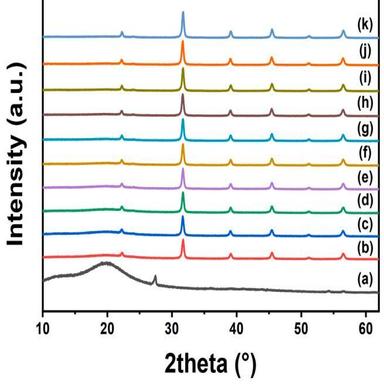
Diffraction pattern overlay of 3D printed BST/ABS composites. (a = 0 wt%, b = 9.10 wt%. c = 16.64 wt%, d = 23.40 wt%, e = 28.56 wt%, f = 33.25 wt%, g = 37.46 wt%, h = 41.24 wt%, I = 44.20 wt%, j = 47.05 wt% and k = 50.27 wt%).